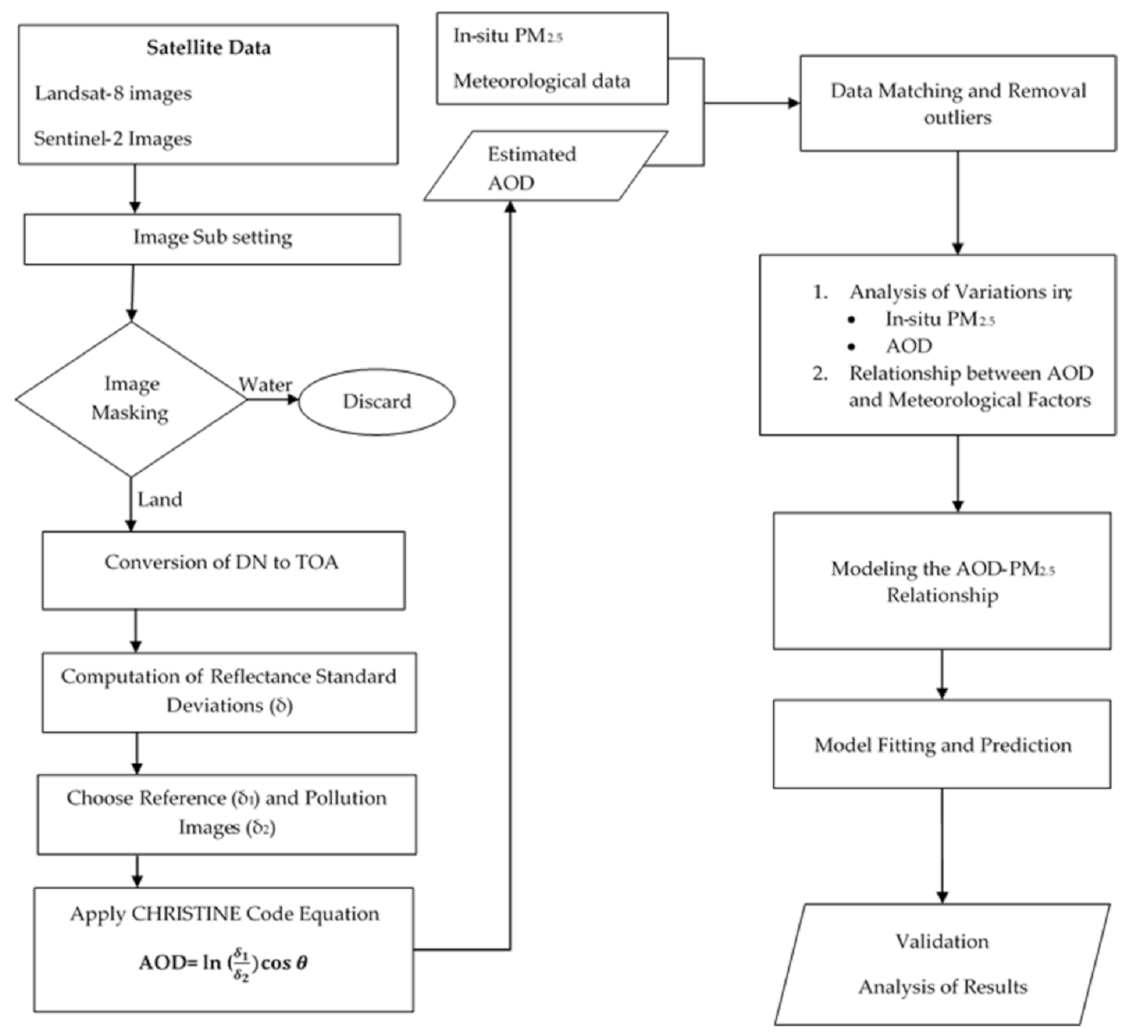
Figure 2. Methodology flow chart used to achieve the study